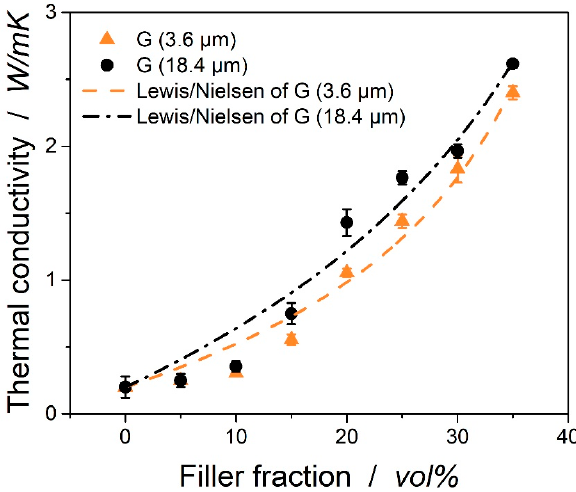
Figure 3. Thermal conductivity of epoxy/filler composites depending on the filler content, fitted with equations from Lewis/Nielsen.